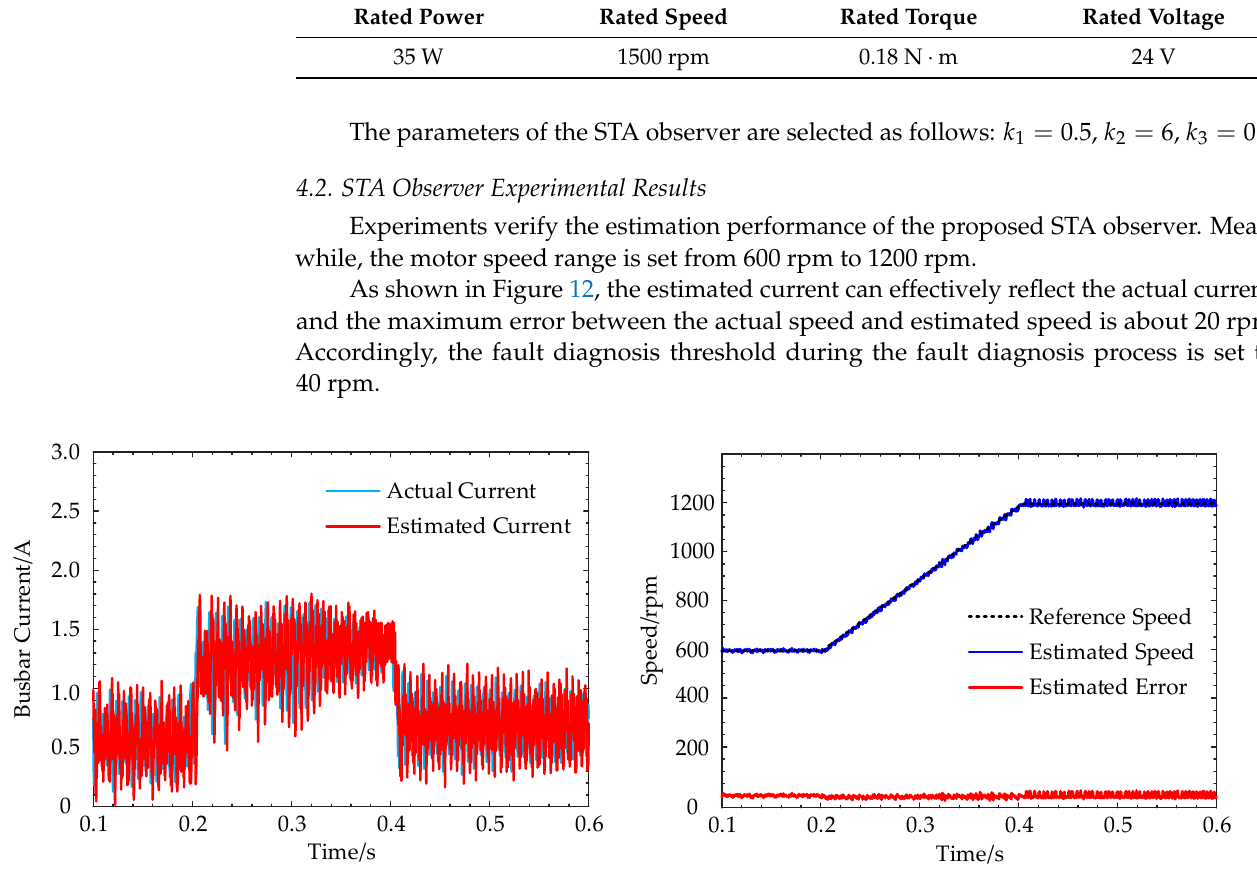
Table 5. Main parameters of the PMBLDC motor.